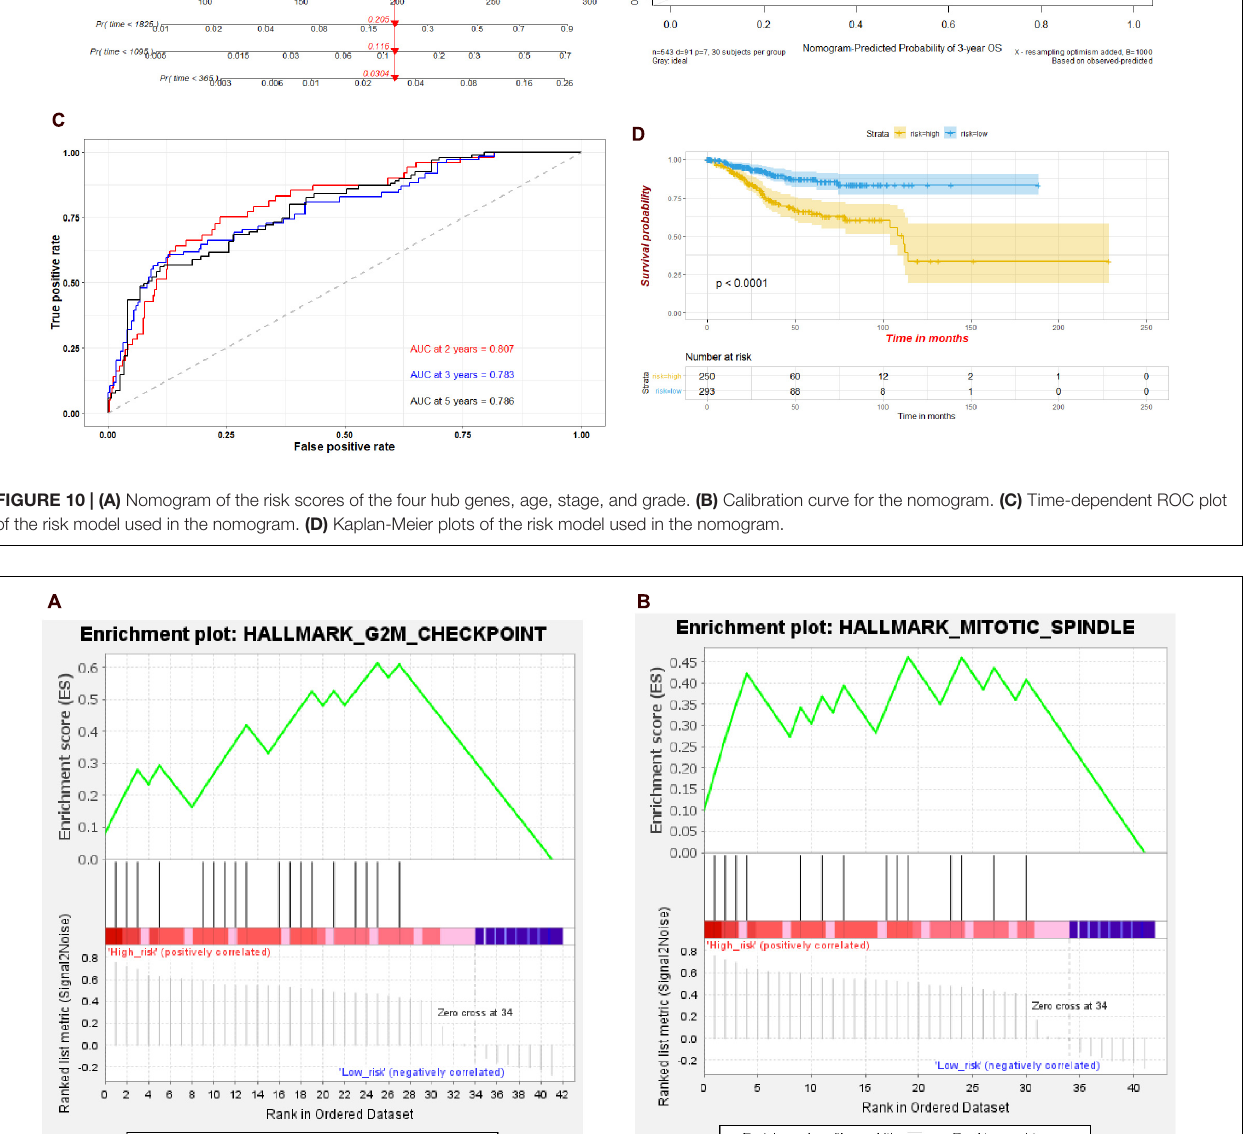
were added to the UCEC dataset. Our analysis based on 543 ECs showed that patients with POLE ultramutated had a favorable prognosis compared with those with the other molecular